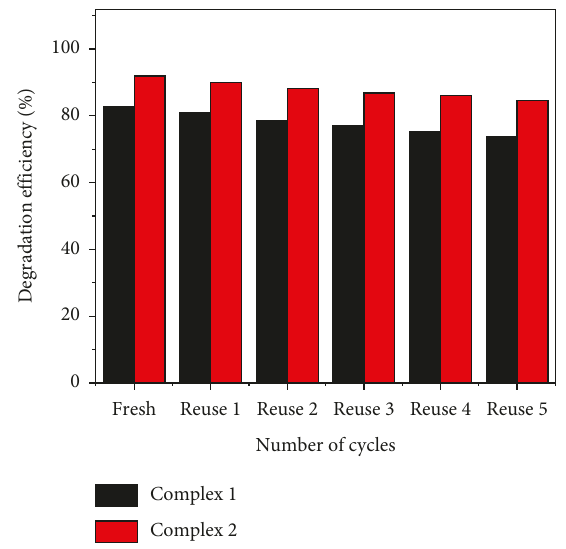
Figure 11: Reusability of the complex 1 and 2 under UV light